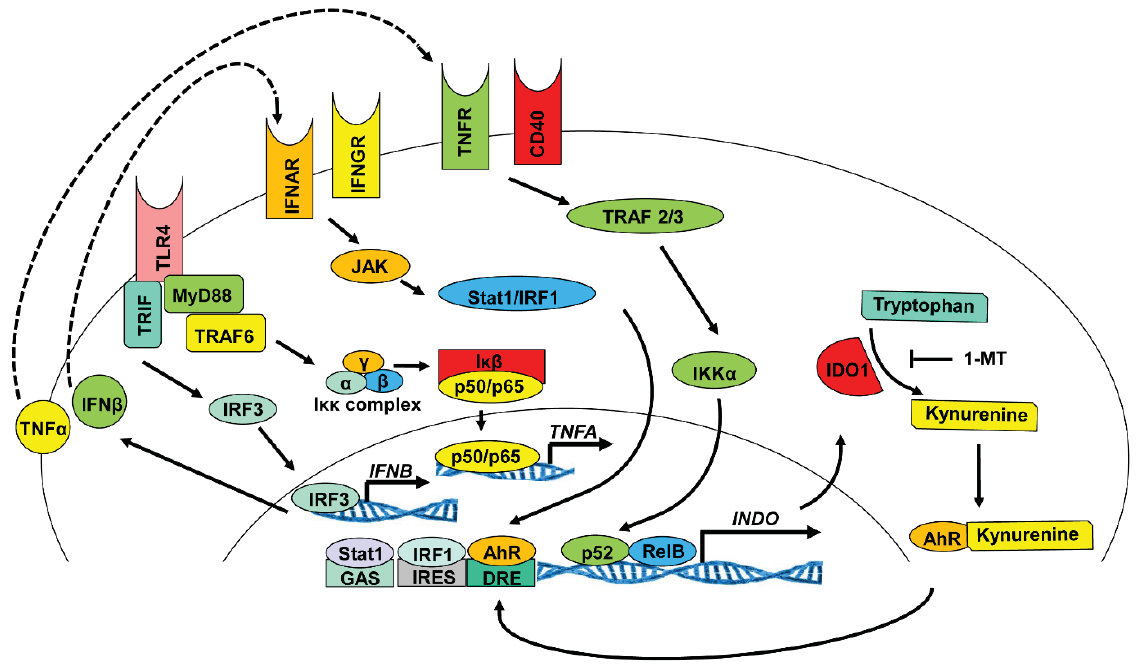
Figure 2. Mechanism of IDO1 induction in dendritic cells: transcription and